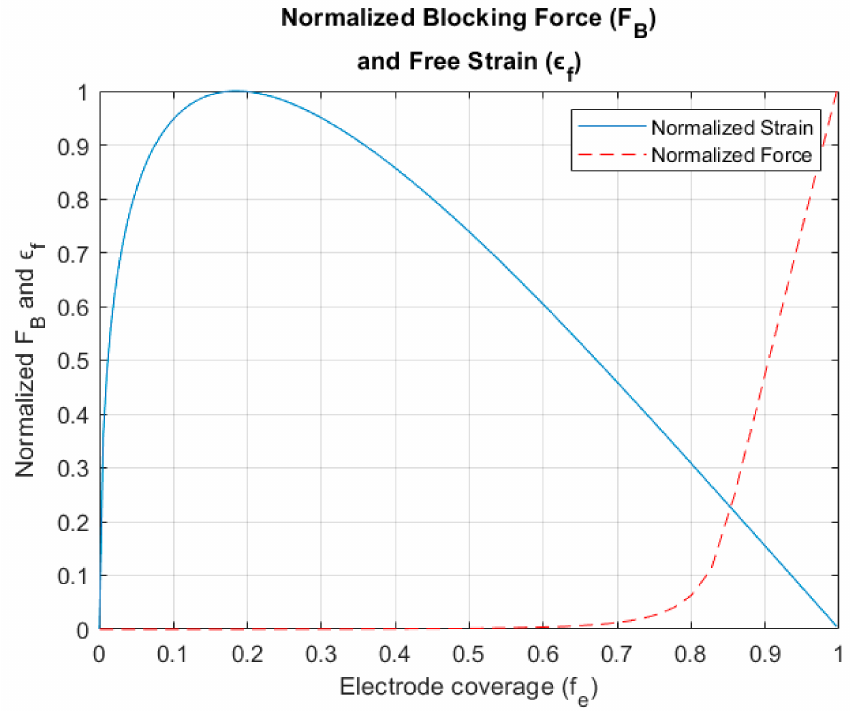
Figure 9. (Above) [3] Graphical depiction of the decay of the free strain ‘ (cid:15) f ’ ( the blue line) and growth of the blocking force ‘F B ’ ( the red line) as electrode coverage ‘f e ’ is increased for the peano HASEL actuator.